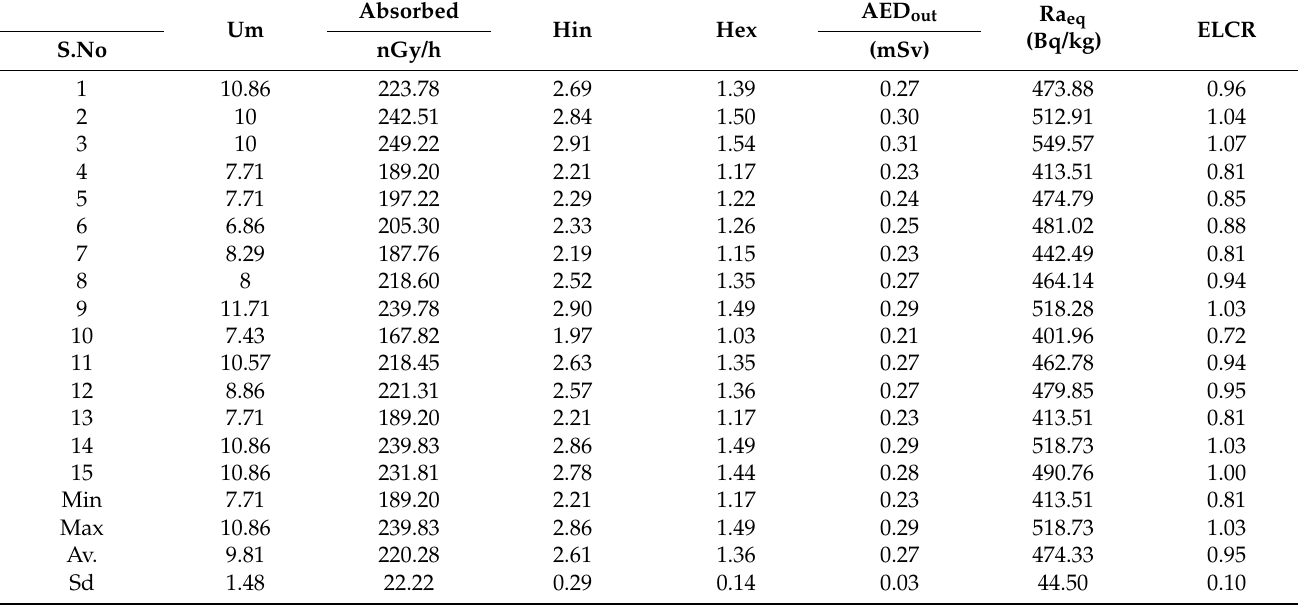
Table 4. Variable radiological parameters of Gebel Qulu El Sabaya